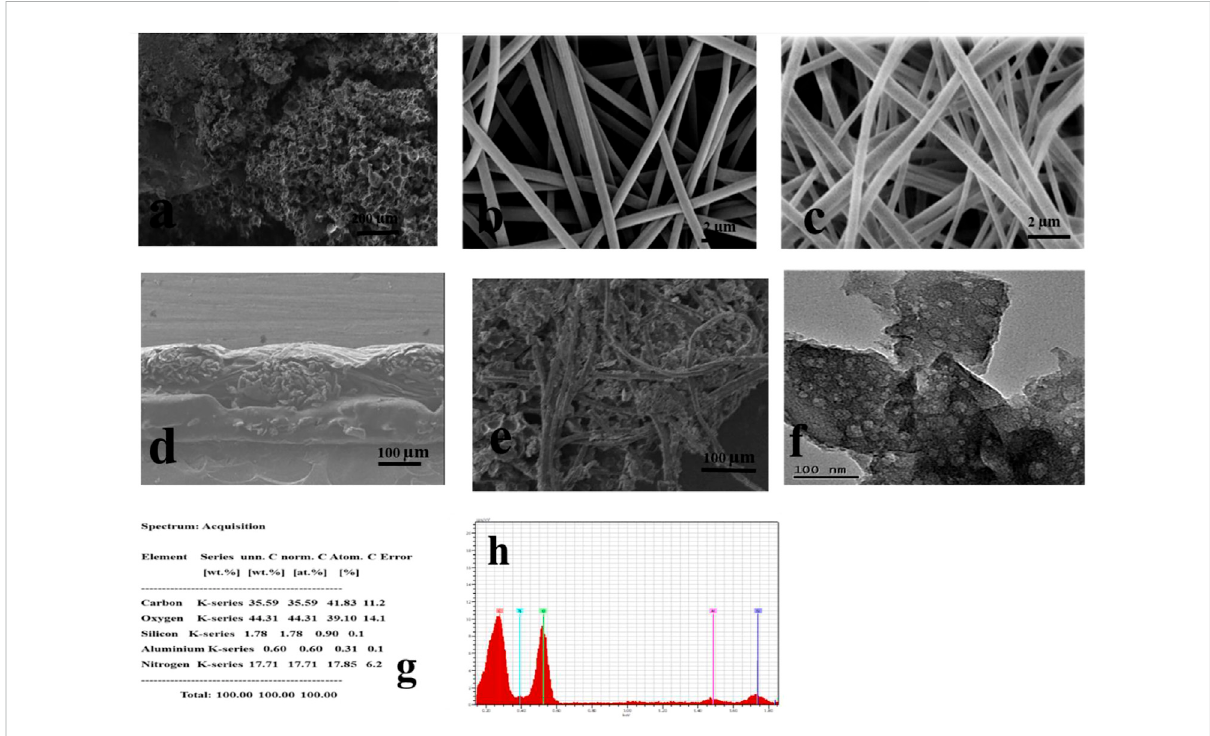
FIGURE 4 Morphology of composite (A). SEM of expanded graphite (B and C). SEM of PAN nano fi bers (D and E). Cross-sectional and front view of composite (F). TEM image of CQDs with PAN (G and H). X-ray (EDX) of composite.